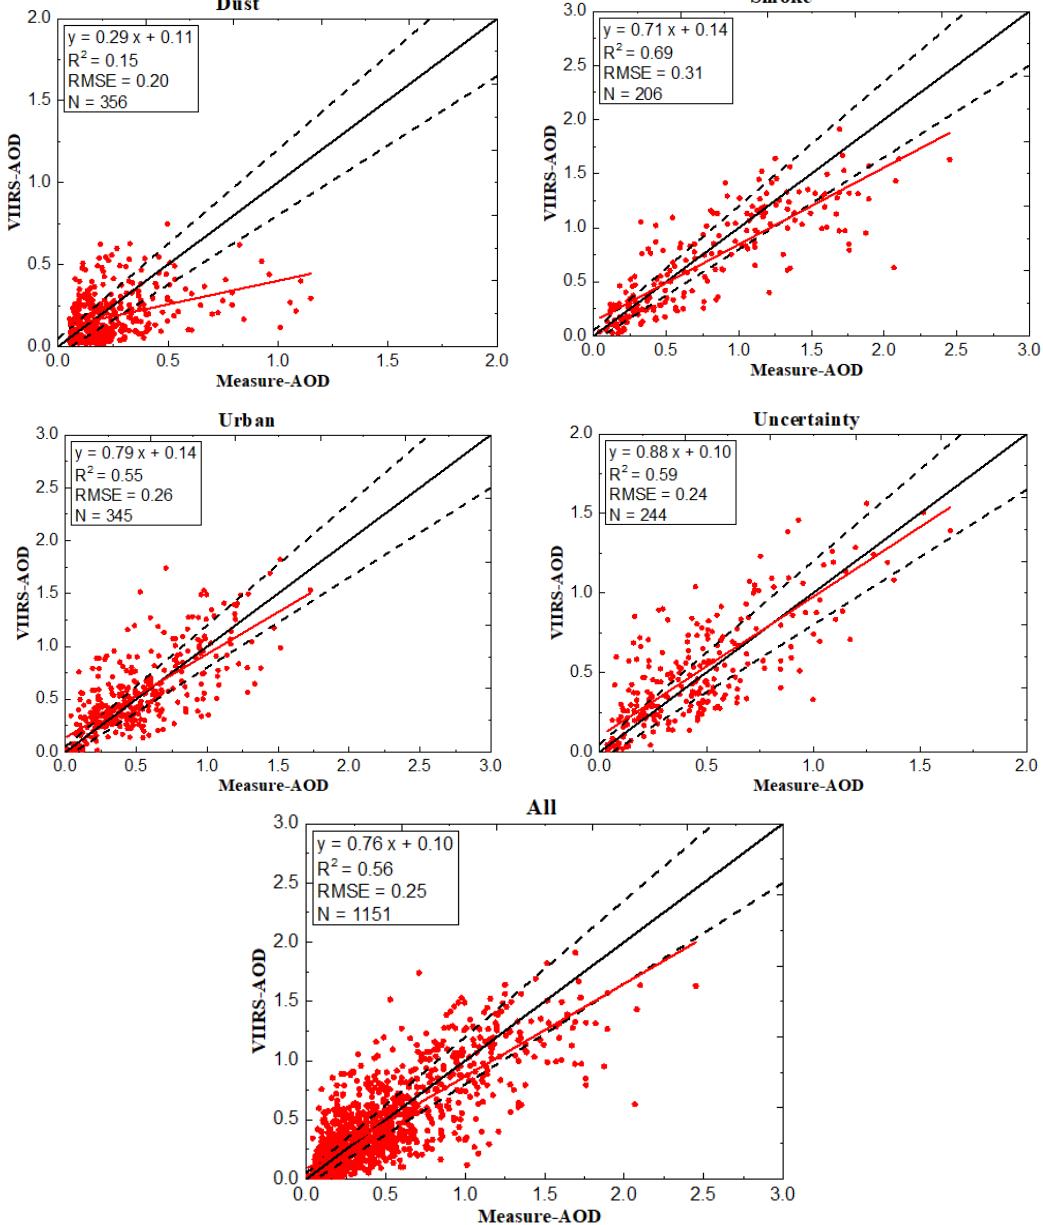
Figure 2. Scatter plots between the different aerosol types of VIIRS AOD and ground-measured AOD. The X axis is the ground-measured, and the Y axis is the VIIRS AOD.